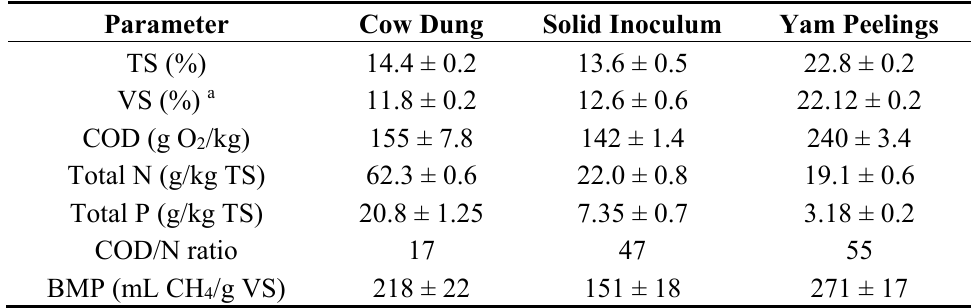
Table 2. Biomass